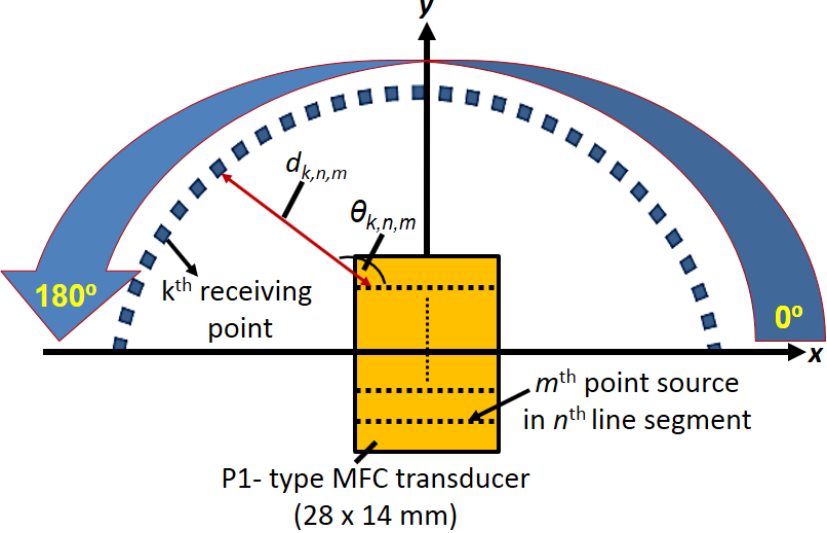
Figure 1. 2D analytical model schematic for estimation of the directivity of P1 MFC transducer [38].